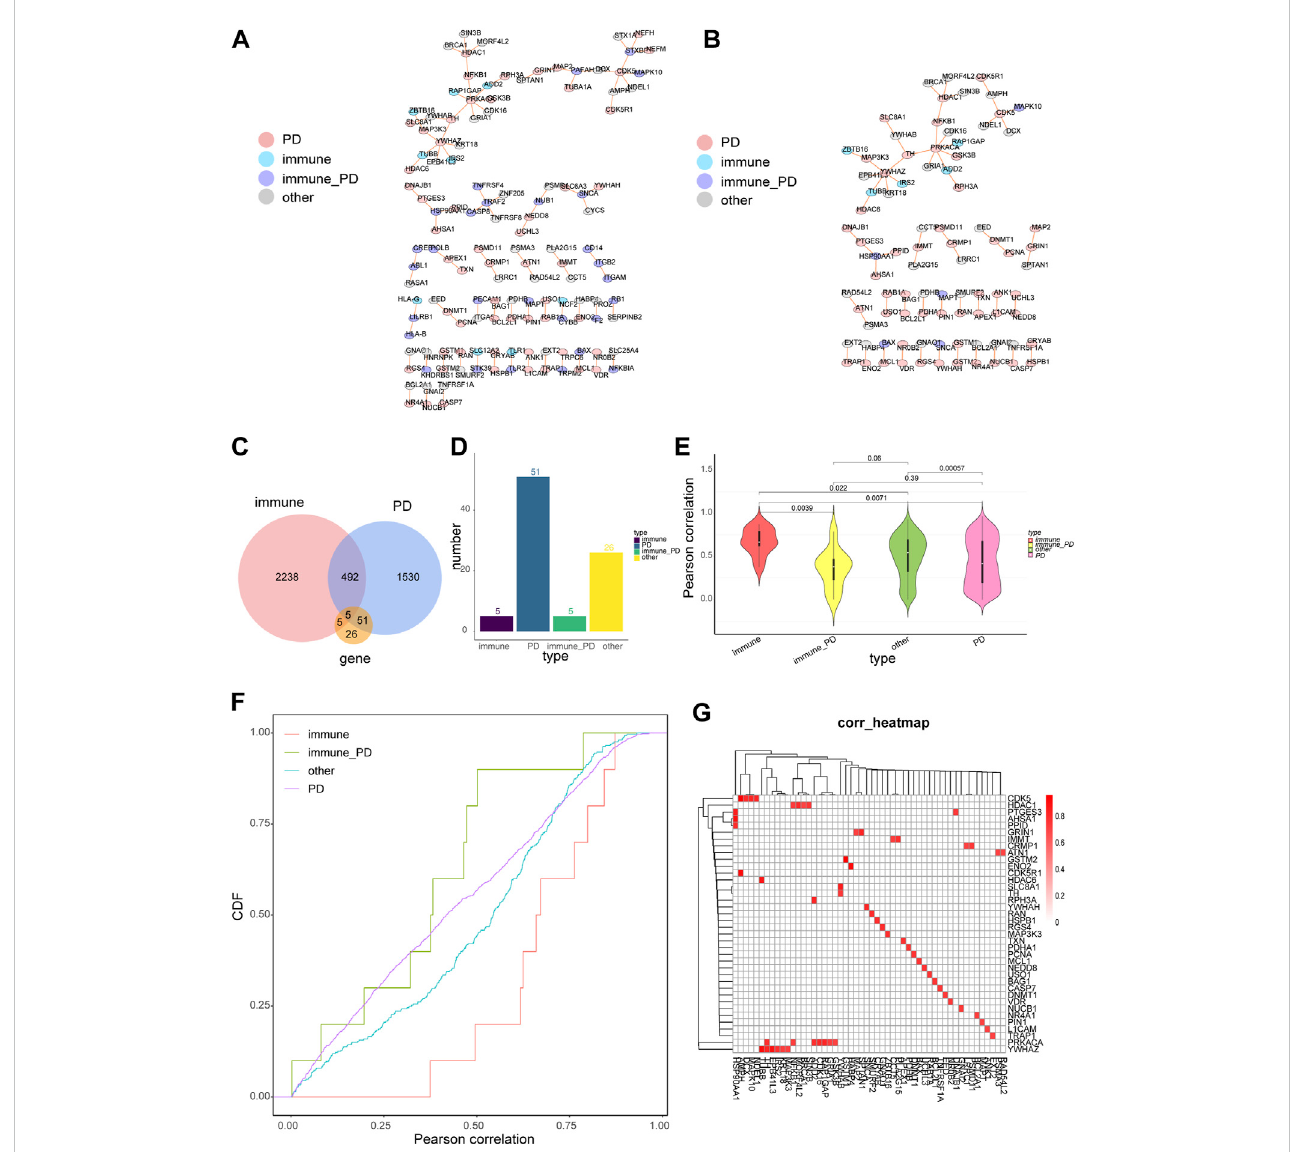
FIGURE 2 The properties of PD-directed neighbor co-expressed network (PDNC network). (A) The global PDNC network. (B) A sub-network was extracted from the PDNC network which comprised only PD genes and their linked genes. (C) A Venn diagram showed the intersections of PD-related genes, immune- related genes, and commonnetwork genes from the sub-network. (D) The histogram chart of the common genes included 5 immune-related genes, 51 PD- related genes,5immune-PDassociated genes,and 26othergenesfromthesub-network. (E) The violinplots ofthePearsoncorrelationsofthepairwise genes inthefour gene categories. Wilcoxon rank-sum test wasappliedto compare thecoexpression correlation coef fi cients between differentgene groups. (F) The cumulative distribution curves of co-expression values (Pearson correlations) for diverse gene types. The vertical axis indicatd the degree of the expression correlationfor eachgene group. (G) Theheatmap suggested thecorrectionsbetweenPDgenesand their linked genes,Horizontalaxisrepresents PD genes linked genes, vertical axis represents PD genes, and red squares indicated |Pearson coef fi cient value| >